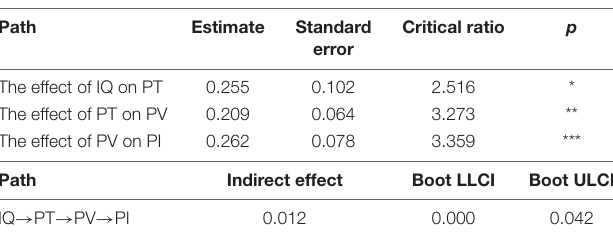
TABLE 5 | Results of path analysis